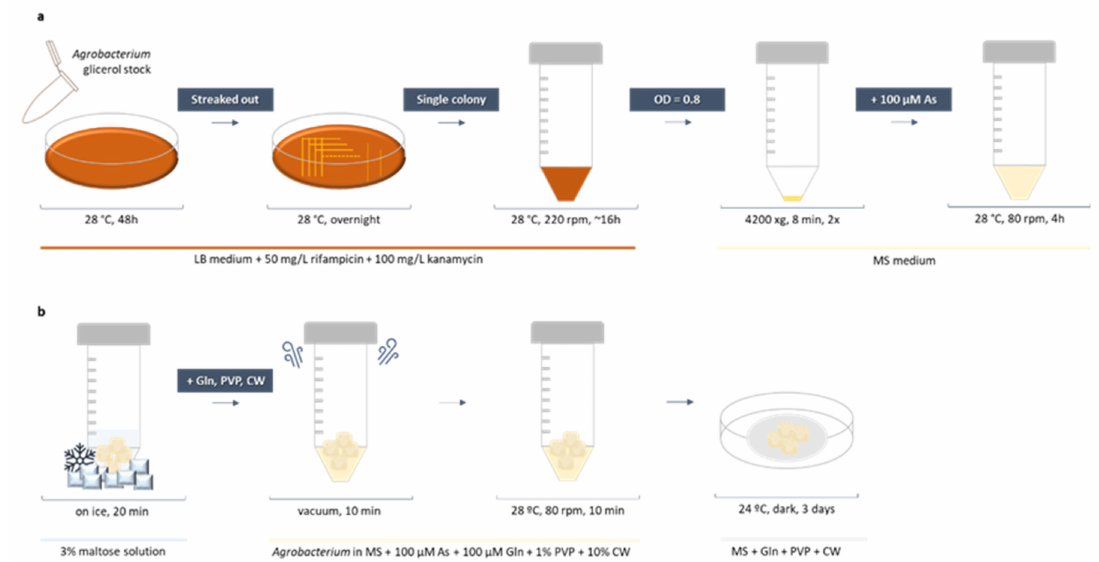
Figure 7. Detailed workflow for Agrobacterium -mediated genetic transformation of embryogenic callus from Solanum betaceum . ( a ) Agrobacterium culture preparation for genetic transformation. ( b ) Tamar- illo embryogenic callus transformation procedure. As—acetosyringone, CW—coconut water, Gln— glutamine, MS—Murashige and Skoog medium, OD—optical density,